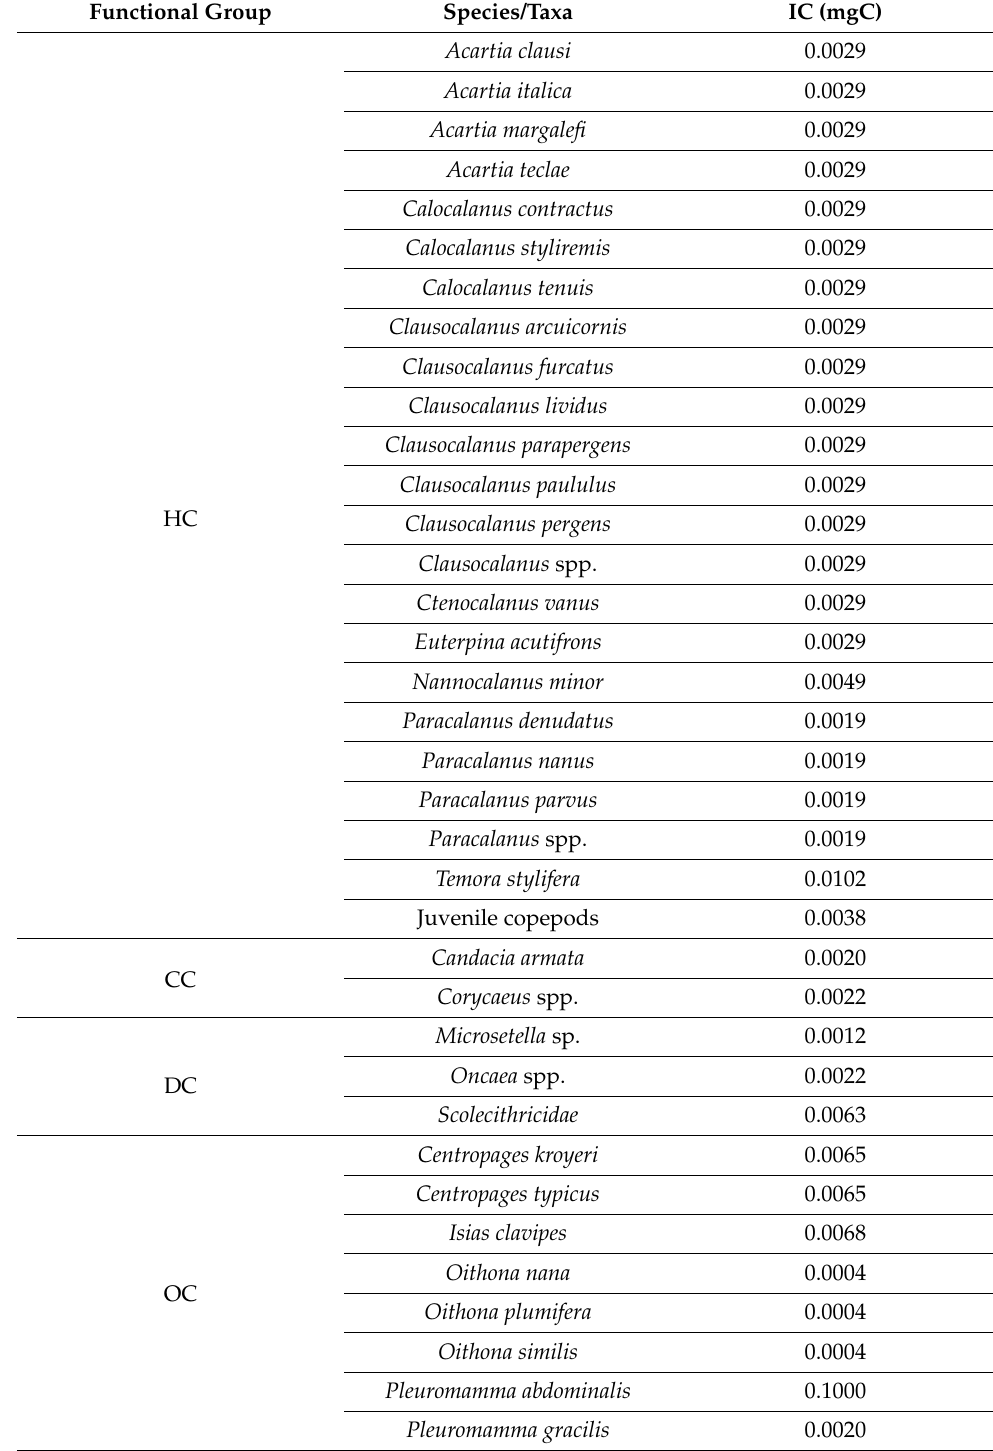
Table A1. Individual Carbon weight for mesozooplankton